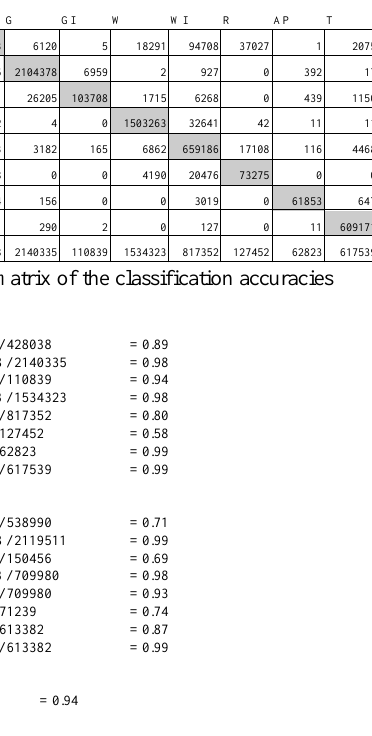
Table 8. Error matrix of the classification